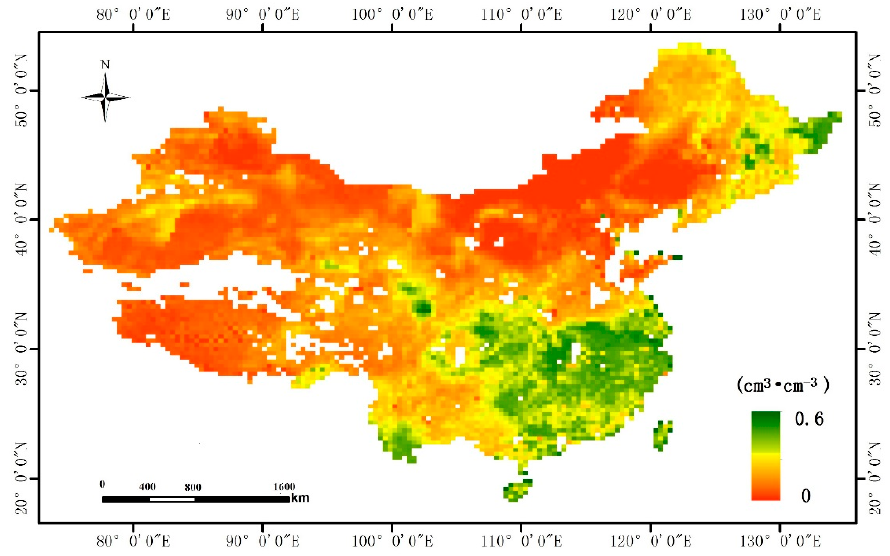
Figure 2. The composited SMAP daily radiometer soil moisture data on 1 June 2016.